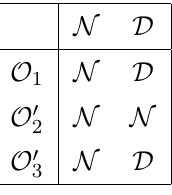
Table 5 . Action of the integration operators {O 1 , O 0 , O 0 } on the non-diagonal N and diagonal D 2 3 parts of the expansions. None of the operators maps the non-diagonal part N into the diagonal D , and the O 1 and O 0 operators even preserve D . These properties allow us to keep the diagonal D 3 part of the expansion in eq. (3.18) in the full MPL form and only expand the non-diagonal N